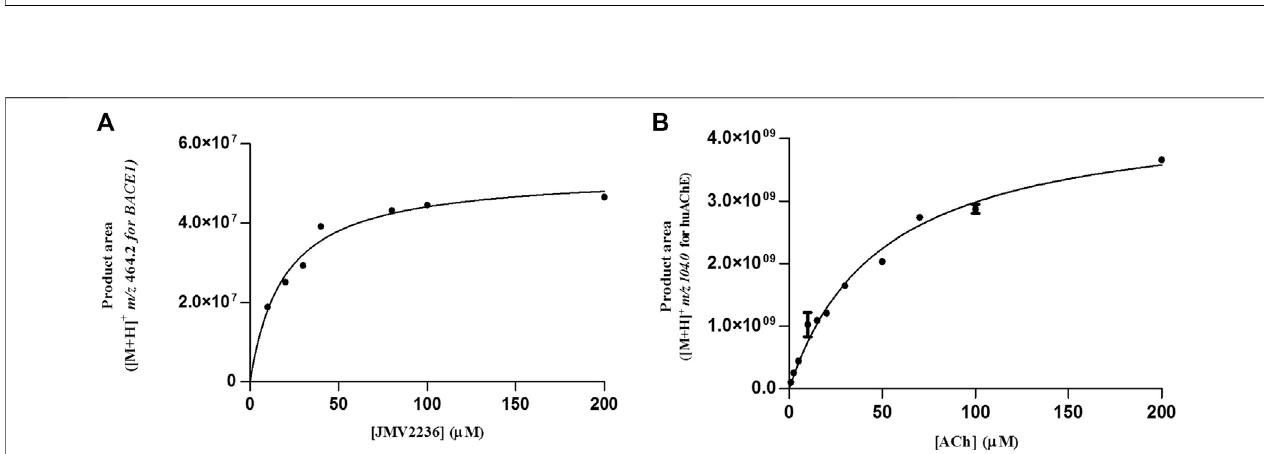
FIGURE 6 | Michaelis-Menten plots of the product area obtained for huAChE (A) and BACE1 (B) in the huAChE+BACE1-ICER-LC-MS system by using ACh and JMV2236 as substrates, respectively.